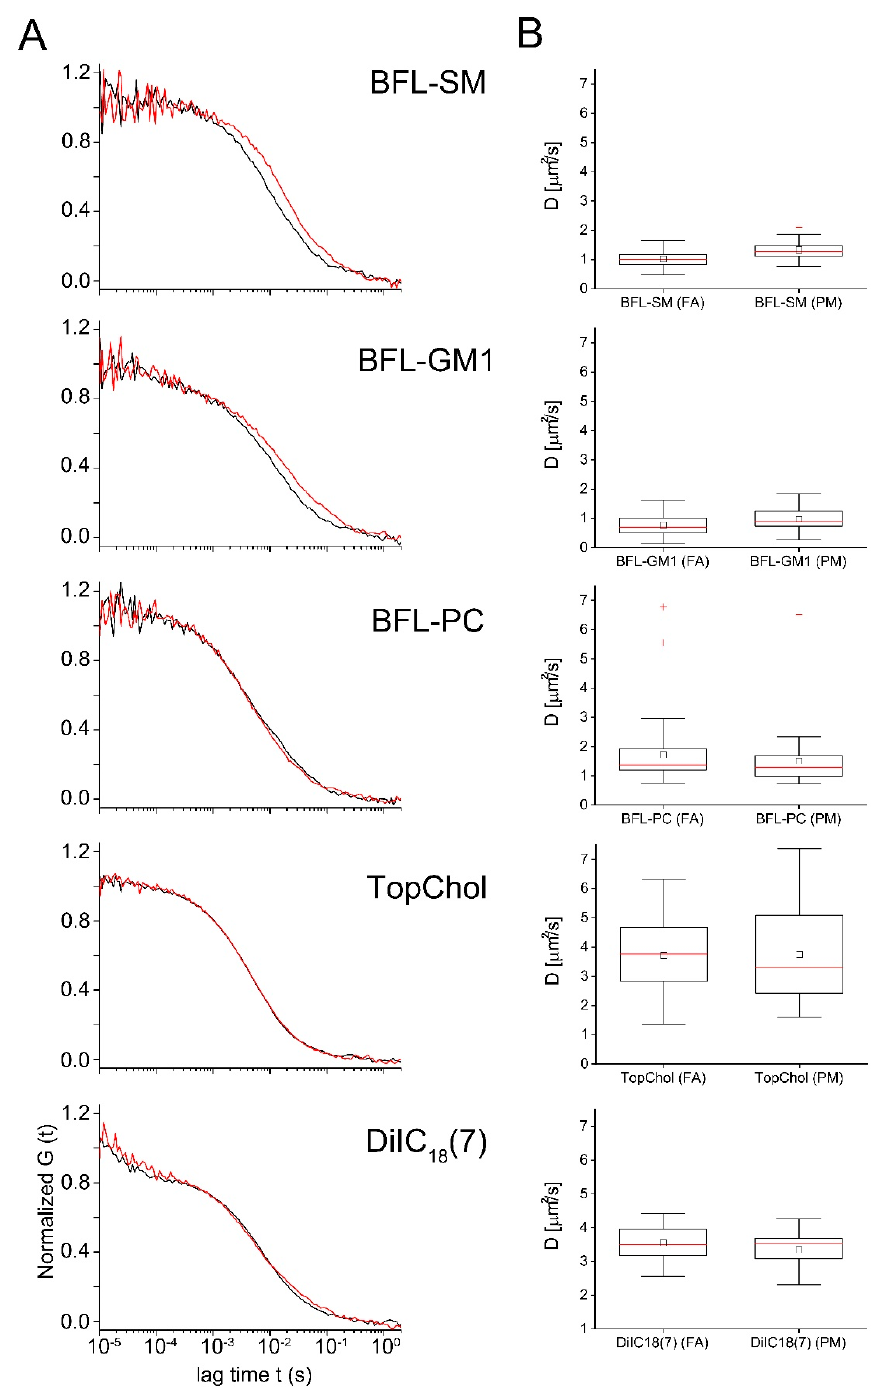
Figure 3. Fluorescence correlation spectroscopy (FCS) measured inside and outside FAs. The indicated fluorescent tracer lipids were incorporated into cells and their di ff usion constants measured with FCS. ( A ) Normalized autocorrelation curves inside (red) and outside (black) of FAs. Representative curves are shown. ( B ) Box plots of the resulting di ff usion constants. Central small square average, red line median, large box is limited by 75% and 25% quartiles, whiskers extreme values of data, and red crosses show outliers (values whose distance to the interquartile box exceeds 1.5 times the box height). Fit results, statistics, and significance levels can be found in Table